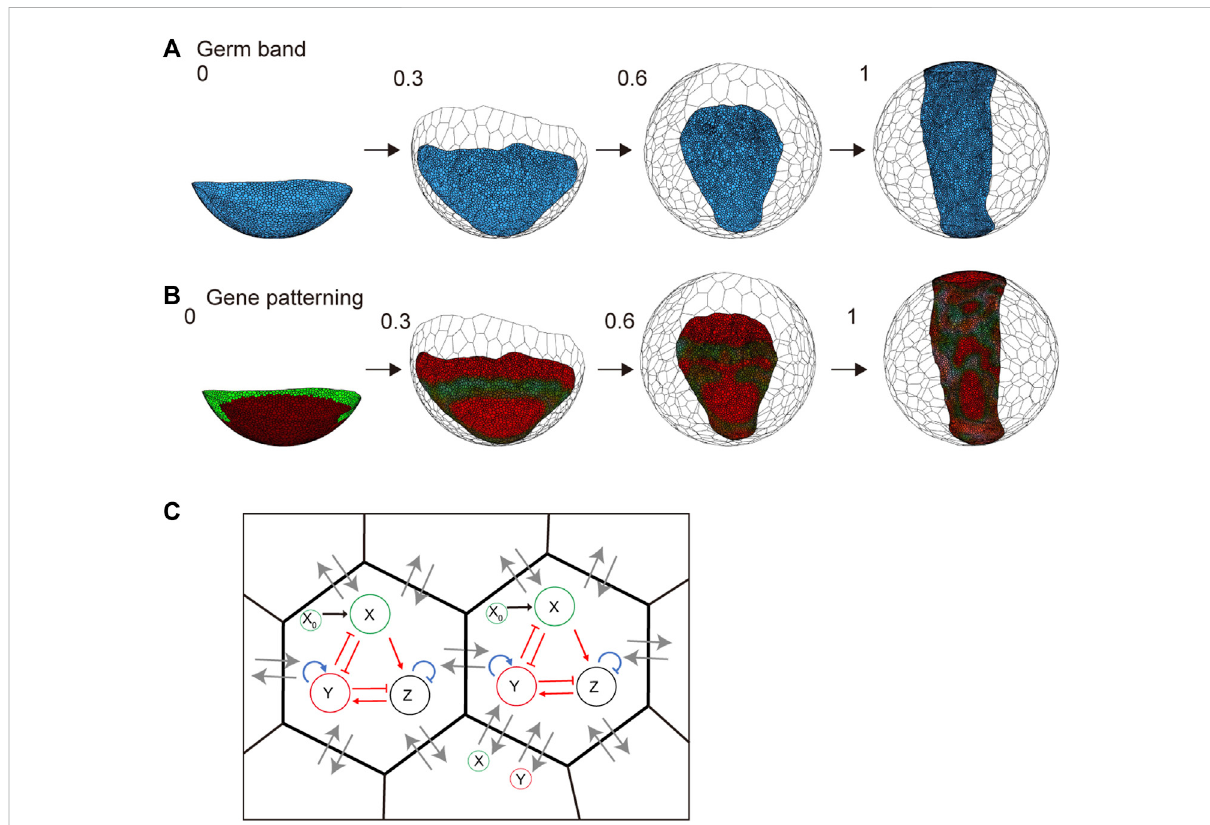
FIGURE 7 Embryo shaping and gene patterning during germ disc development. (A) Body axis formation of the germ band in P. tepidariorum . The embryo sizeis570 μ mdiameter,composedof1,500( t =0)to6,000( t =1.0)epithelialcells.ThesettingsforeachcellparameteraredescribedintheMethods section. The blue colored cells represent embryonic cells, and the colorless cells represent extraembryonic cells. (B) Gene expression patterning during embryo shaping. The collars indicate the molecules X (green) and Y (red) de fi ned in (C) and Methods section. Numbers on each panel represent the developmental time (initial state t = 0 to after the deformation t = 1.0). See Supplementary Movie S5 for details. (C) Gene expression network in a cell and diffusion between neighboring cells. Red arrows indicate the regulations between two molecules, while blue arrows indicate self-regulation. Black arrows indicate the input from the initial pattern of X = X 0 ( (B) left). Lines with arrowheads indicate promotion; those with end bars indicate inhibition. Gray arrows indicate molecular diffusion ( X and Y ) between neighboring